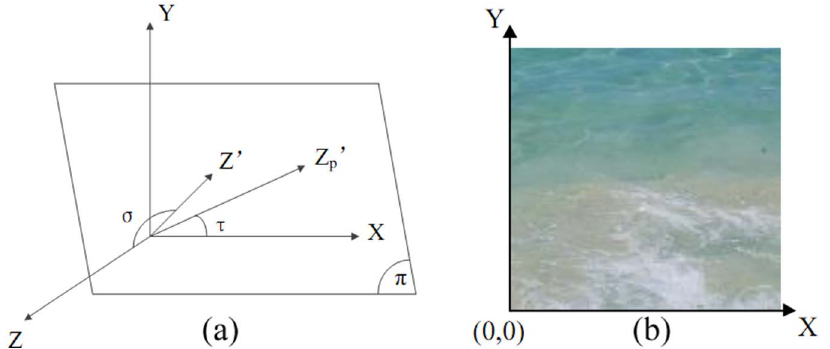
Figure 3. Definition of slant and tilt angle from 3D space and image coordination. (a) XY is image plane; Z is normal of image plane; p is texture plane; Z’is normal of texture plane; Zp’ is the projection of Z’ on XY; s is the slant angle (between Z and Z’); t is the tilt angle (between X and